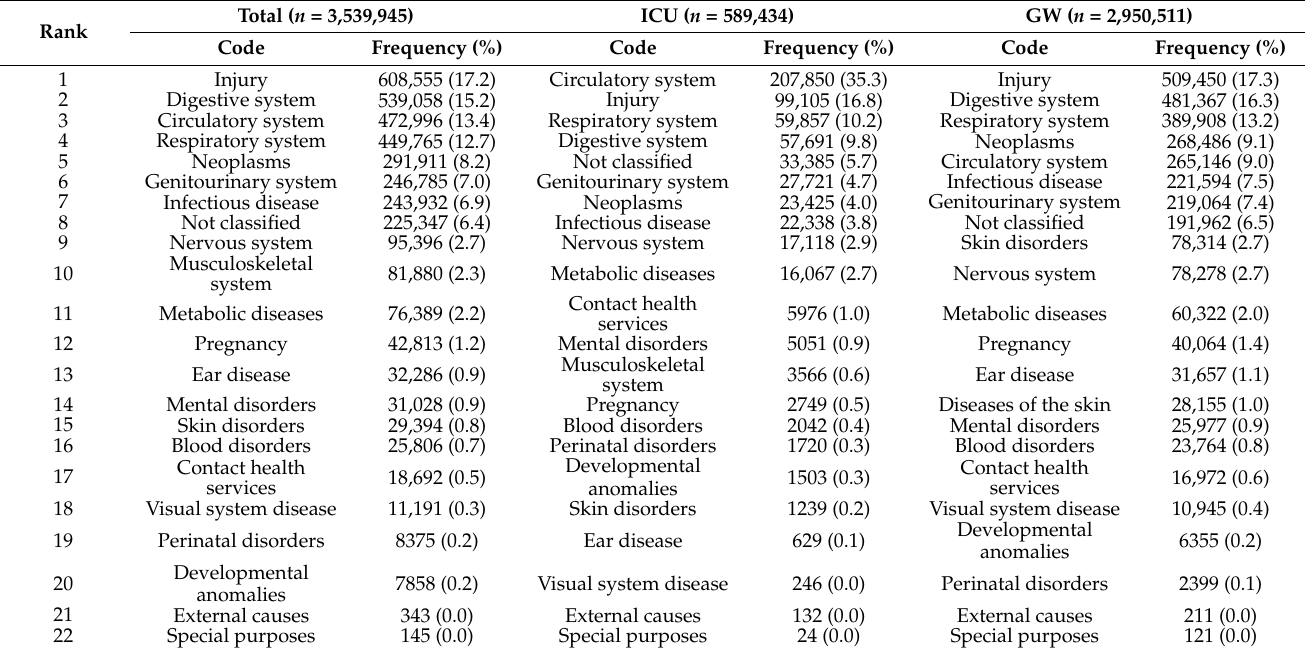
Table 2. Frequencies of disease classes according to admission